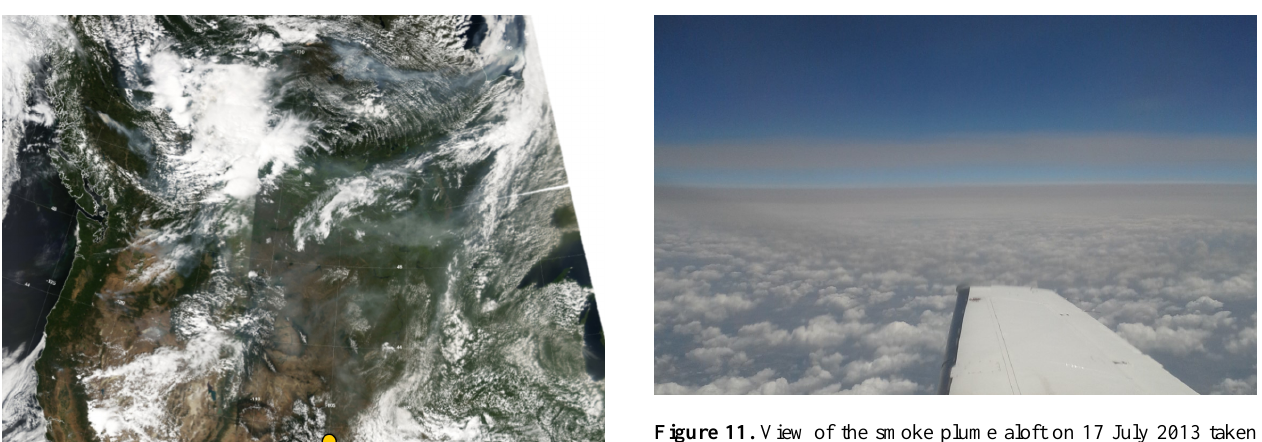
Figure 11. View of the smoke plume aloft on 17 July 2013 taken from the B200. Photo credit: Tim Berkoff.